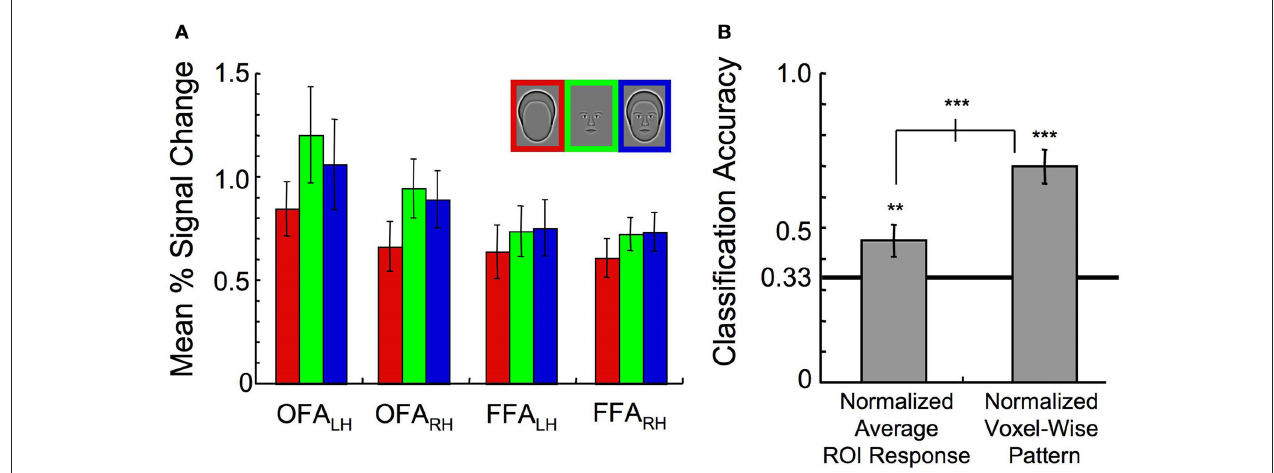
classifier, or the entire normalized voxel-wise pattern of activation across all ROIs was used as input to a pattern classifier (error bars, 95% c.i.). Asterisks indicate the level of significance for both independent t -tests and paired t -tests (* p < 0.05, ** p < 0.01, *** p <